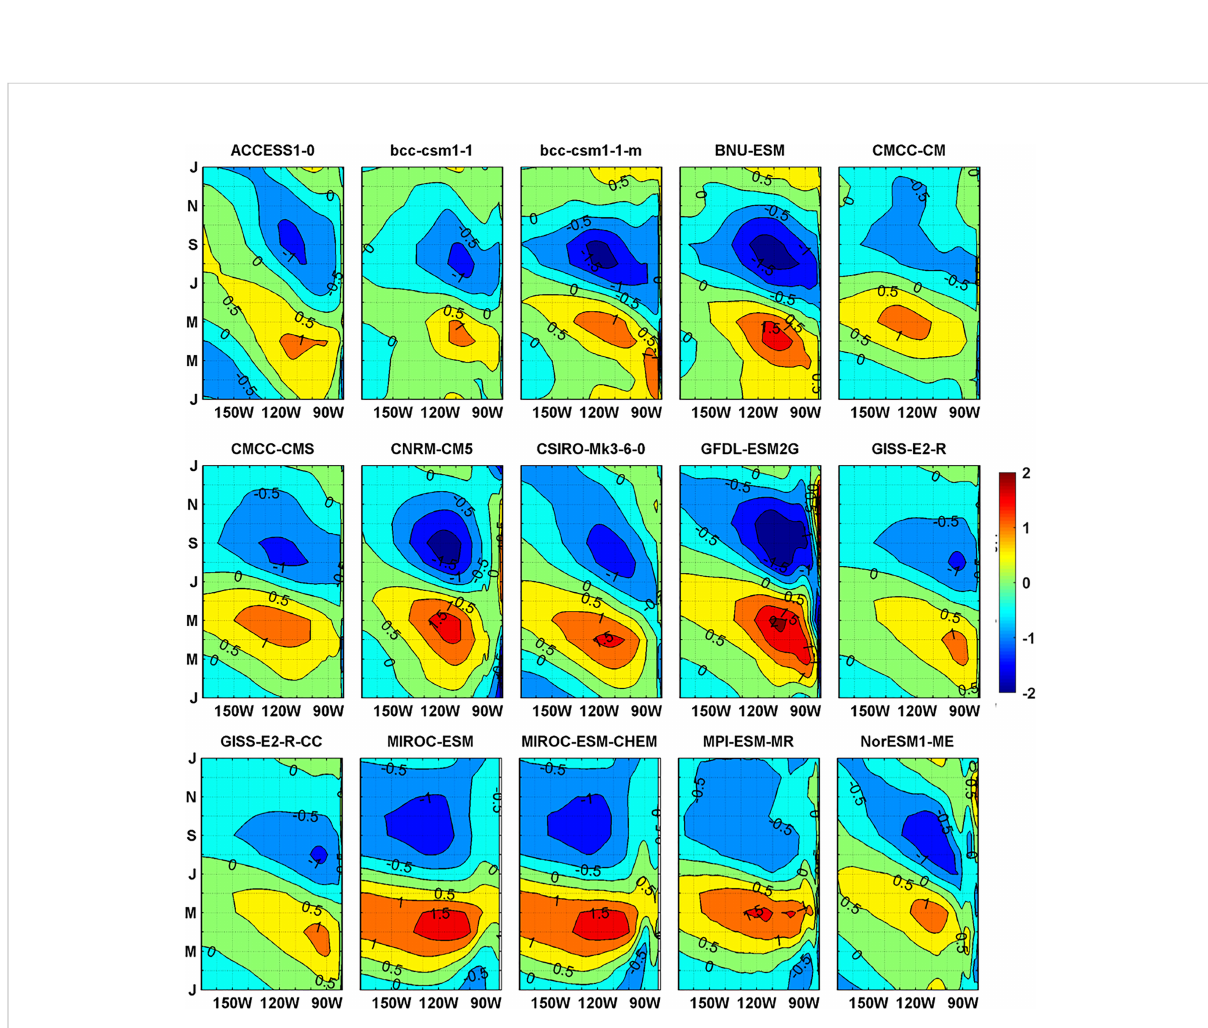
FIGURE 2 Same as Figure 1B, but for the individual 15 models in the historical